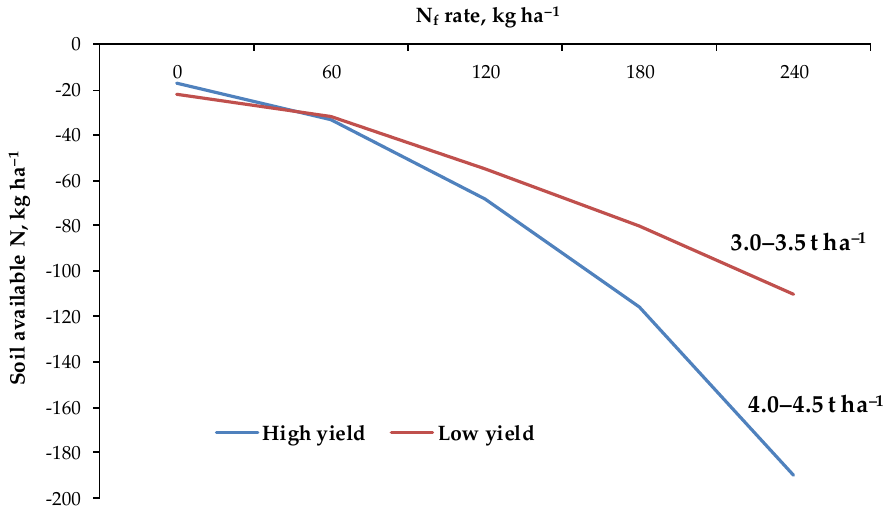
Figure 11. The amount of the soil and fertilizer N depleted during the Yield Formation Period (YFP) depending on nitrogen (N f ) rate. Key: High, Low yield of winter oilseed rape. (Based on Grzebisz et al. [35].